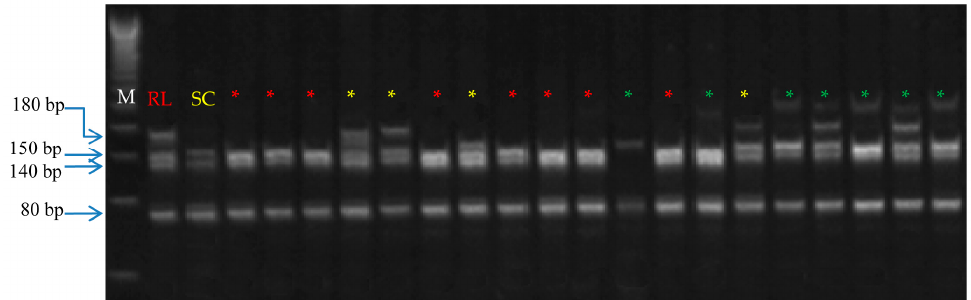
Figure 5. PAGE gel showing PCR amplification of F87 primer using DNAs from seedlings of RL × SC: yellow labeled zygotic seedlings; red labeled nucellar seedlings; and green labeled extra alleles of zygotic seedlings. M is molecular marker of 50 bp.